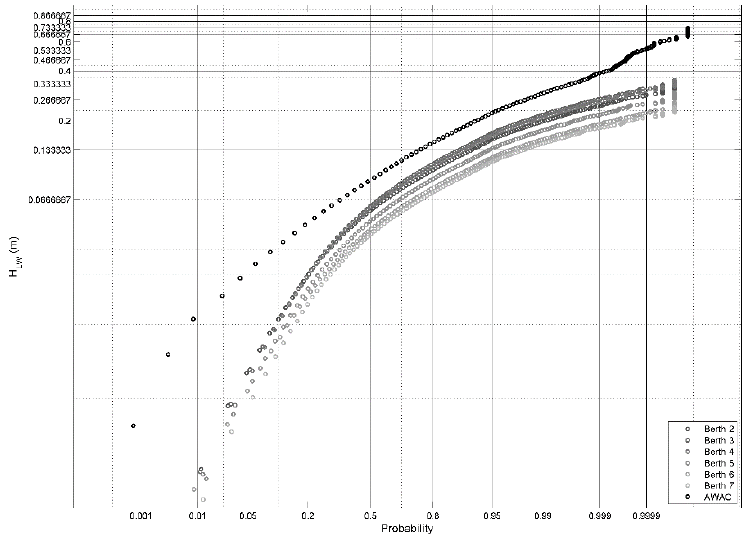
Figure 6. Annual mean distribution for H LW at Berths 2 to 7.